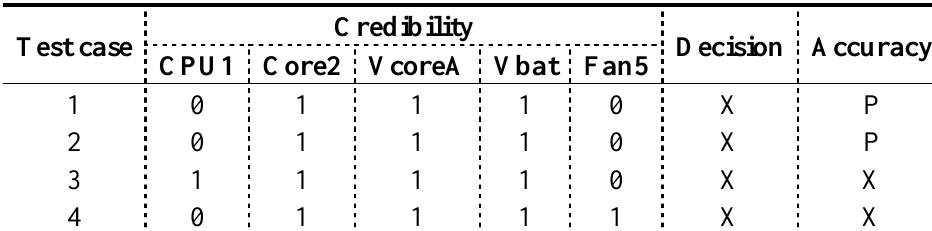
Table 6. Results of the stand alone diagnosis.